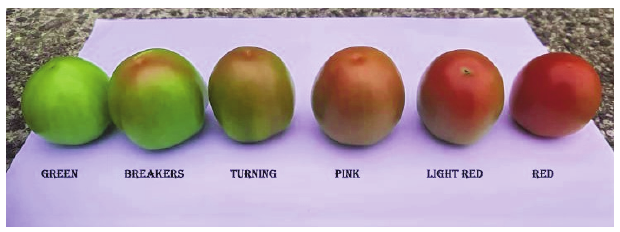
Fig. 2 ­ Standard tomato ripening color